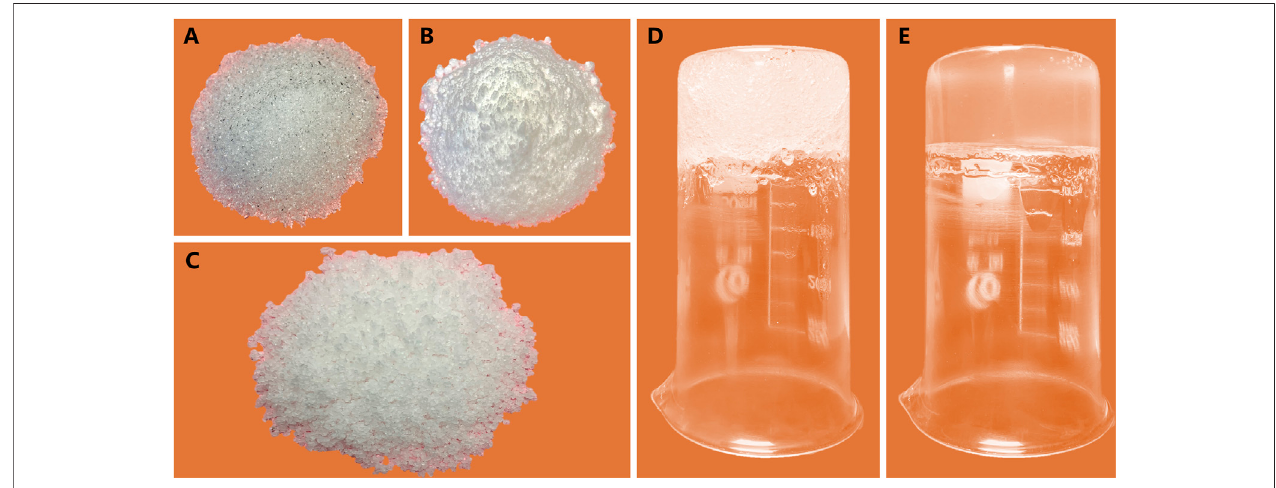
FIGURE1| ComponentsandpreparationprocessofTCS: (A) fusedquartz; (B) hydrophobicfumedsilicapowder; (C) mixtureoffusedquartz,hydrophobicfumed silica powder and mixed mineral oil; (D) unsaturated cemented soil (white and opaque); (E) saturated cemented soil (colorless and transparent).